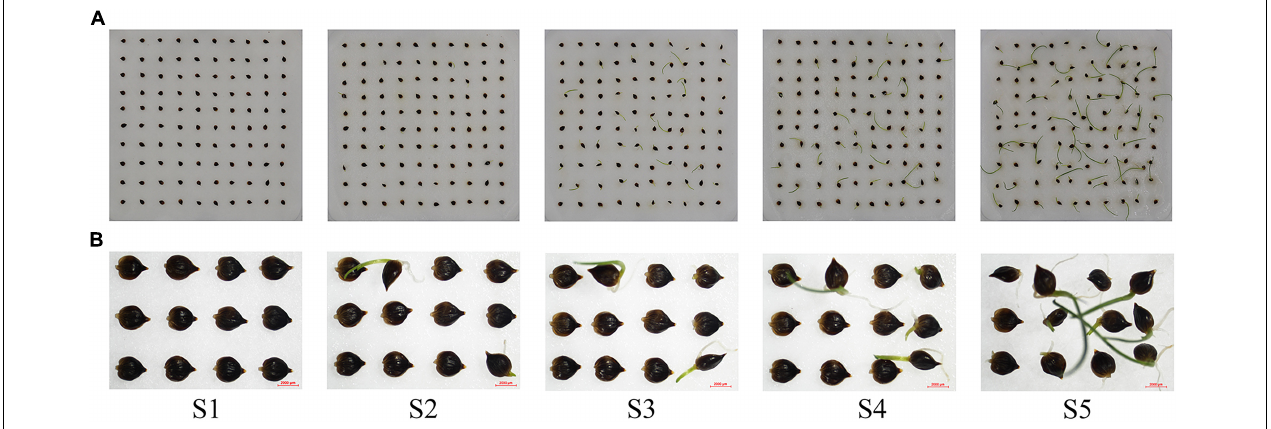
FIGURE 1 | Seed germination status of Carex rigescens . (A) Seed germination of C. rigescens at different germination stages. (B) Part germination of C. rigescens seeds at different germination stages.